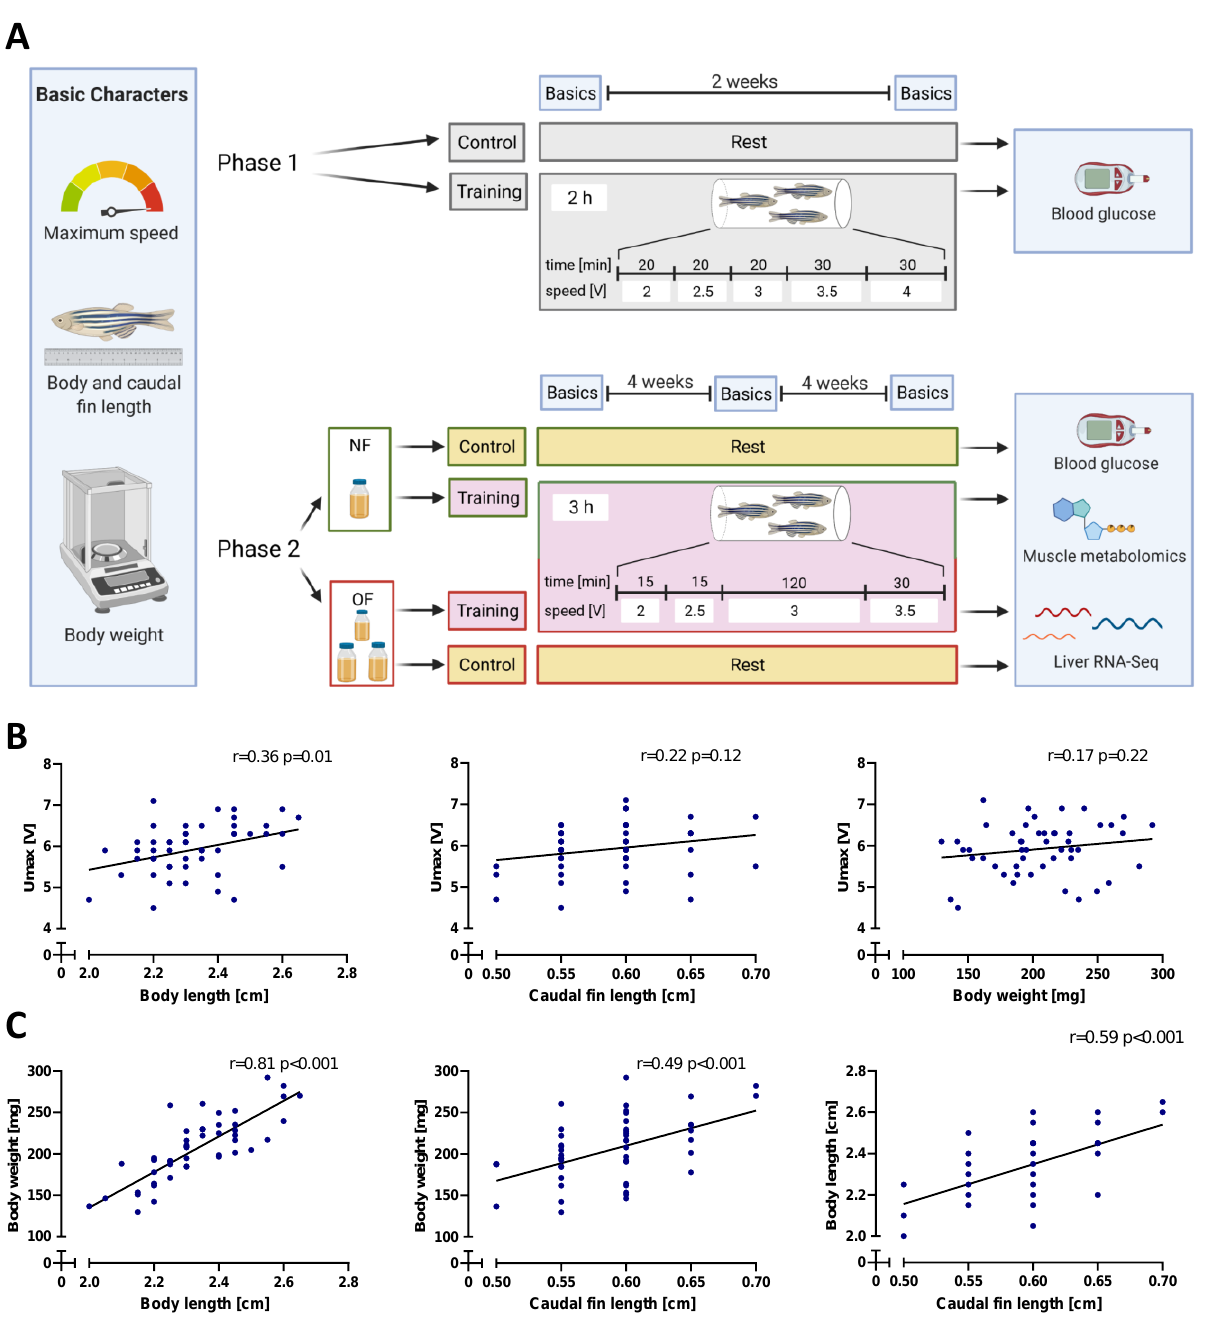
Figure 1. Experiment setup and initial basic character correlations. ( A ): The experiment was split into two phases. Phase 1: 2-week training; Phase 2: 8-week training including overfeeding. Training protocols differed in current velocity and total duration. Upon completion of the phases, fish were sacrificed, blood glucose was measured, and in phase 2 experiment metabolomics and RNA-Seq data were determined. NF: normal feeding, OF: overfeeding. ( B ): positive training-independent correlations of body length, caudal fin length and body weight with the maximum speed (Umax). ( C ): Positive correlations between zebrafish body length, body weight and caudal fin length. Simple linear regression lines were fitted. N = 50 fish per correlation analysis, r: Pearson correlation coefficient, p : two-tailed p value.